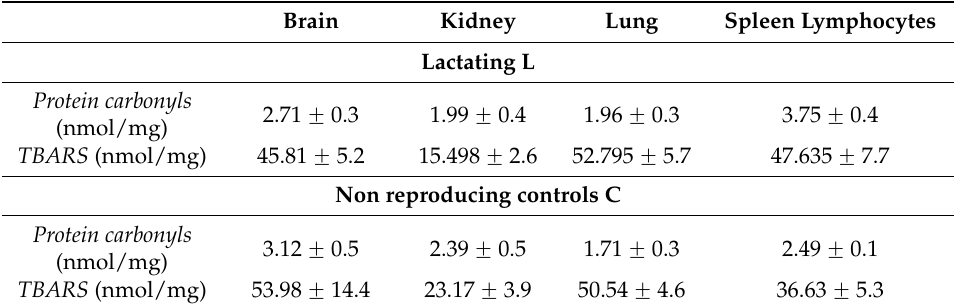
Protein carbonyls and TBARS (means ˘ SEM) from lactating and non-lactating C57BL/6NCrl